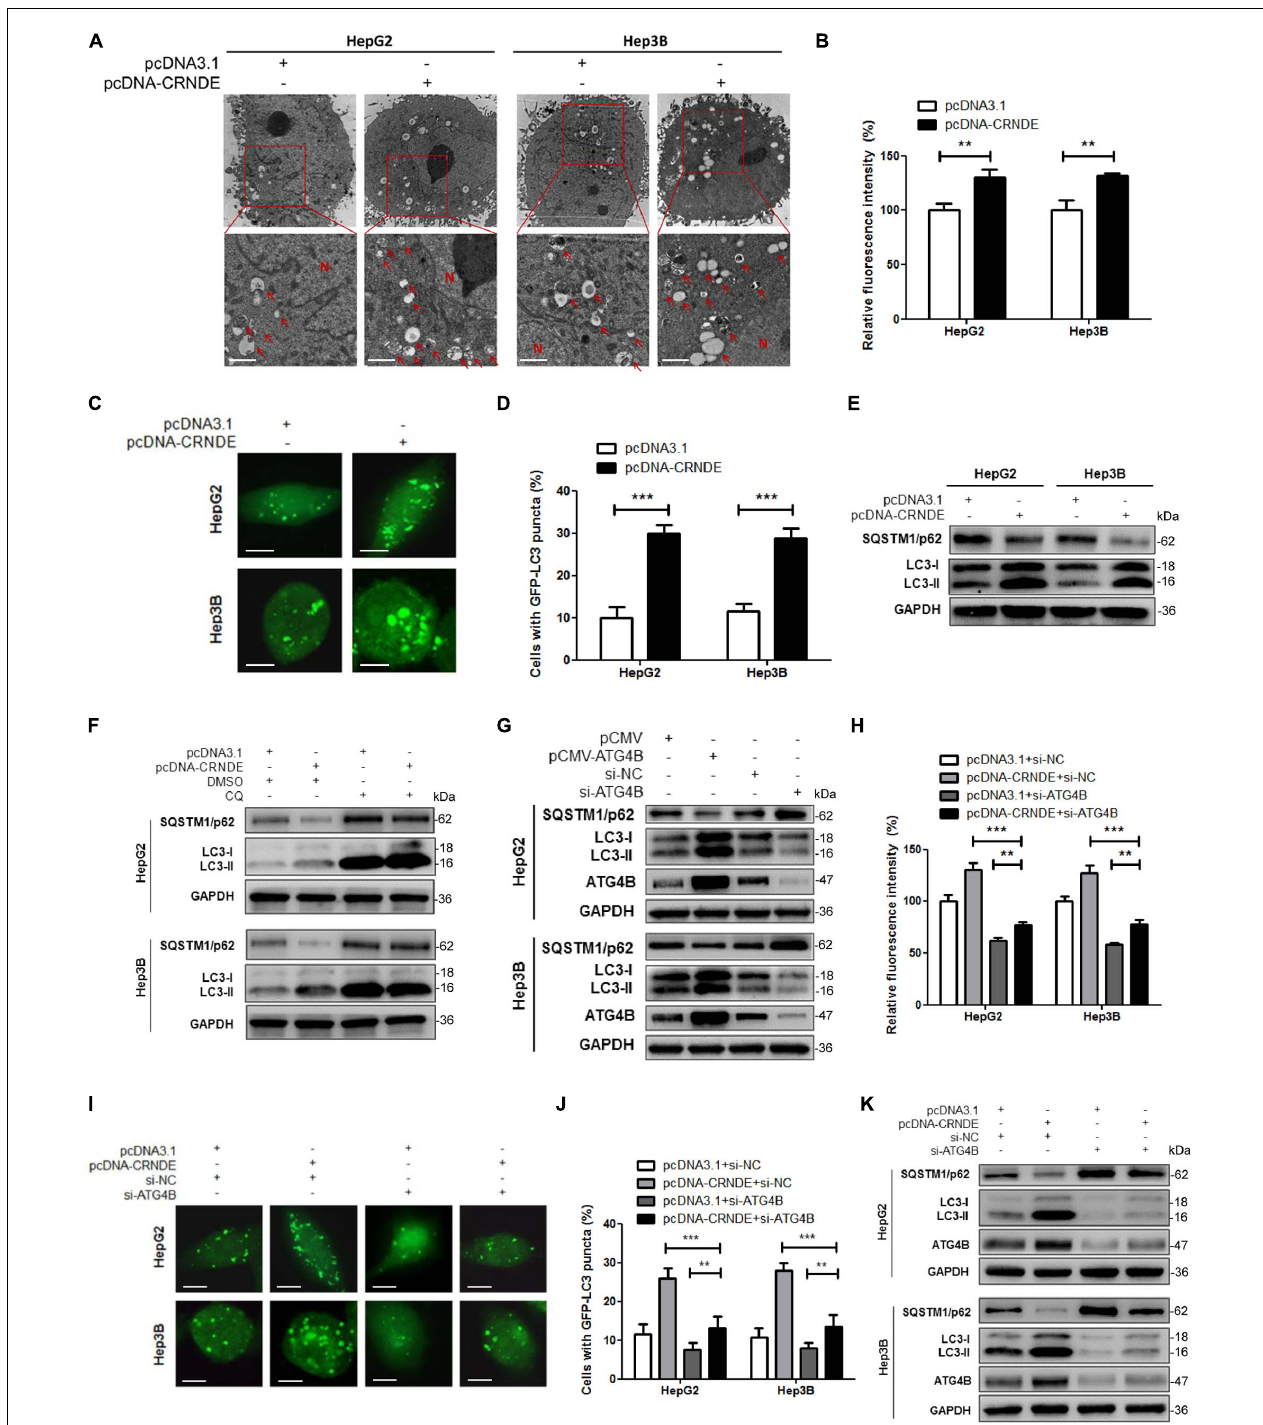
FIGURE 2 | CRNDE induces autophagy in HCC cells through upregulating ATG4B. (A,B) HepG2 and Hep3B cells were transfected with pcDNA-CRNDE (or pcDNA3.1) for 24 h, then autophagic vesicles in the cells were observed by TEM (scale bar: 1 µ m; N, nuclei; red arrows indicate the typical autophagosomes or autolysosomes) (A) , and fluorescence intensity of autophagosomes was analyzed by flow cytometry (B) . (C,D) HepG2 and Hep3B cells were co-transfected with pcDNA-CRNDE (or pcDNA3.1) and GFP-LC3 vector for 24 h, then the green fluorescent GFP-LC3 puncta in the cells were observed under a laser confocal microscope (scale bar: 5 µ m) (C) , and the percentage of the cells containing five or more GFP-LC3 puncta was quantified using a fluorescence microscope (D) . (E) HepG2 and Hep3B cells were transfected as in A, and then the levels of SQSTM1/p62 and LC3 were measured by Western blot. (F) HepG2 and Hep3B